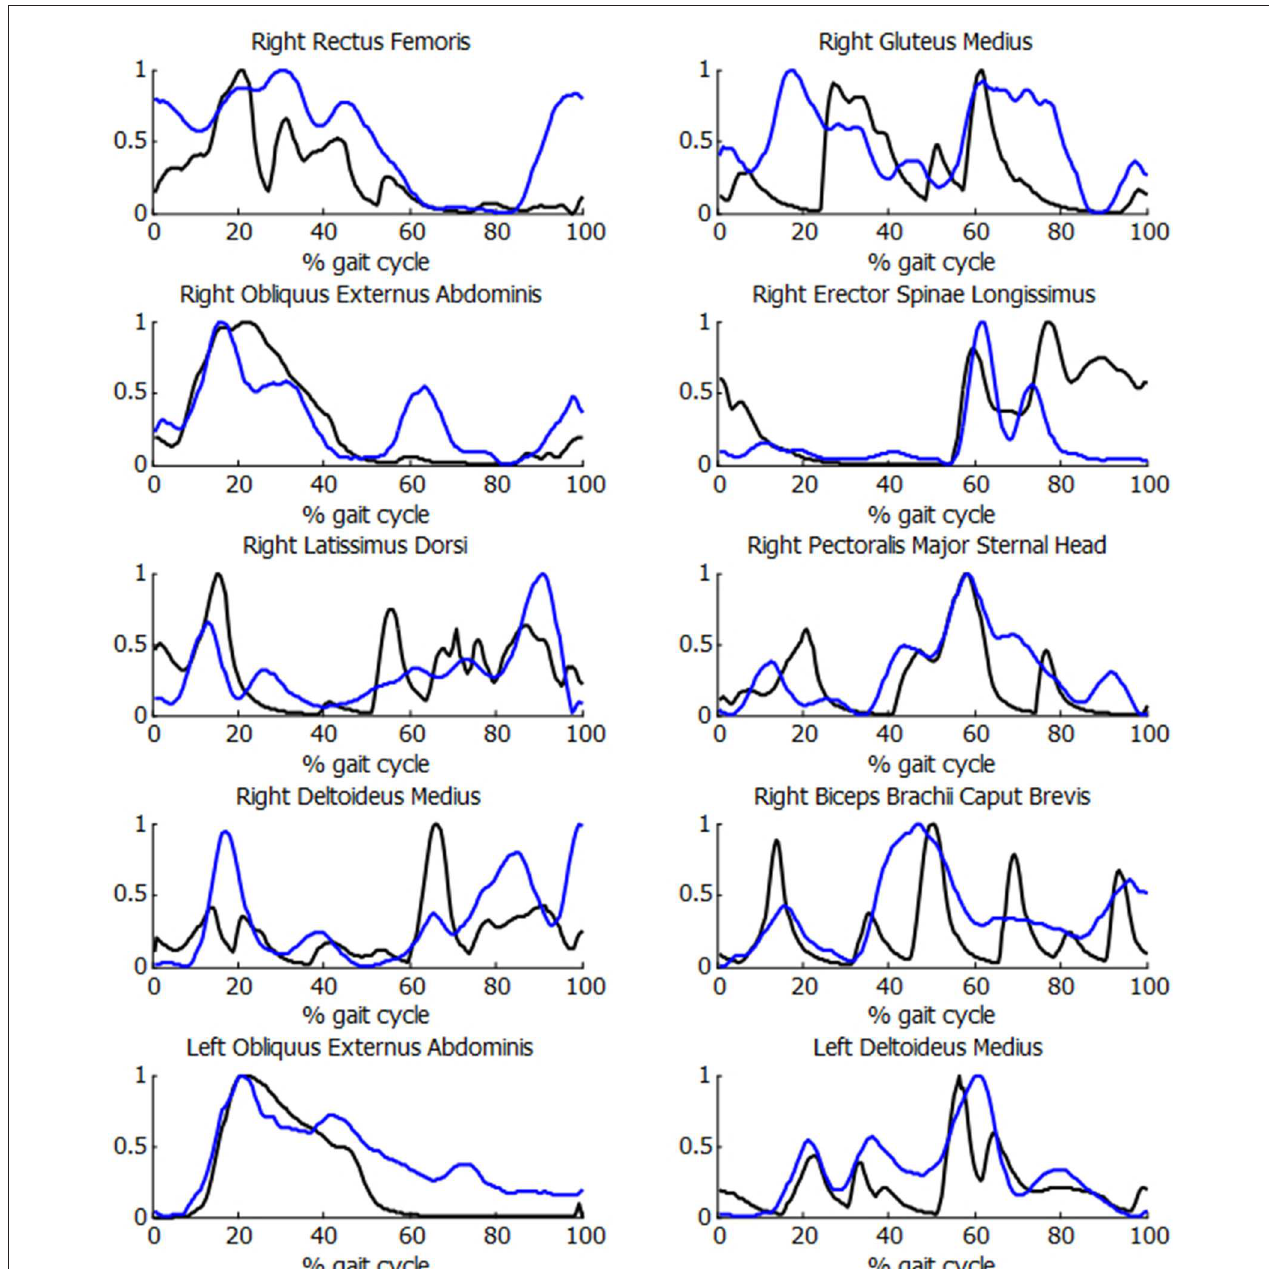
FIGURE 7 | Comparison of normalized muscle activations (black) and normalized EMG measurements (blue) during the crutch-orthosis-assisted gait of a SCI